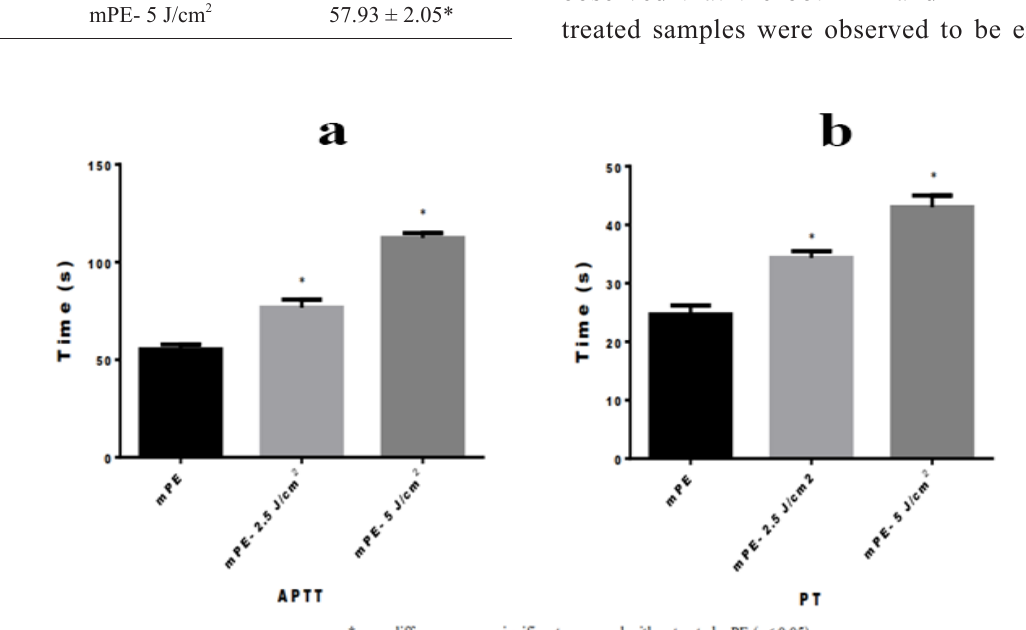
Figure 2 - a ) APTT and b ) PT assessment of mPE, mPE-2.5 J/cm 2 and mPE-5 J/cm 2 treated samples. The mean of the mPE and mPE-2.5 J/cm 2 and mPE-5 J/cm 2 treated samples along with their standard deviation is indicated from three individual experiments. Further mean differences between the mPE and the mPE-2.5 J/cm 2 and mPE-5 J/cm 2 treated samples were significant